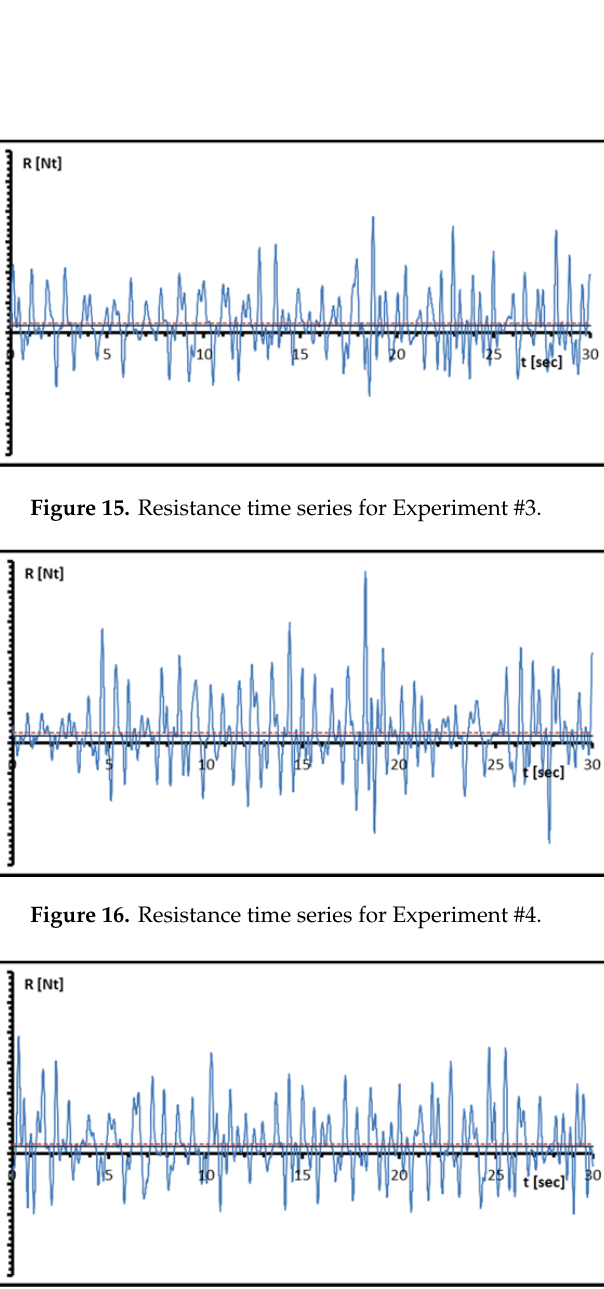
Figure 17. Resistance time series for Experiment #5.